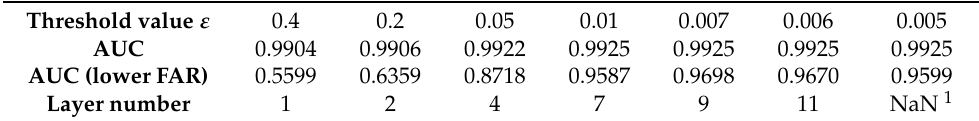
Table 6. The number of iterations and detection performance for different ε